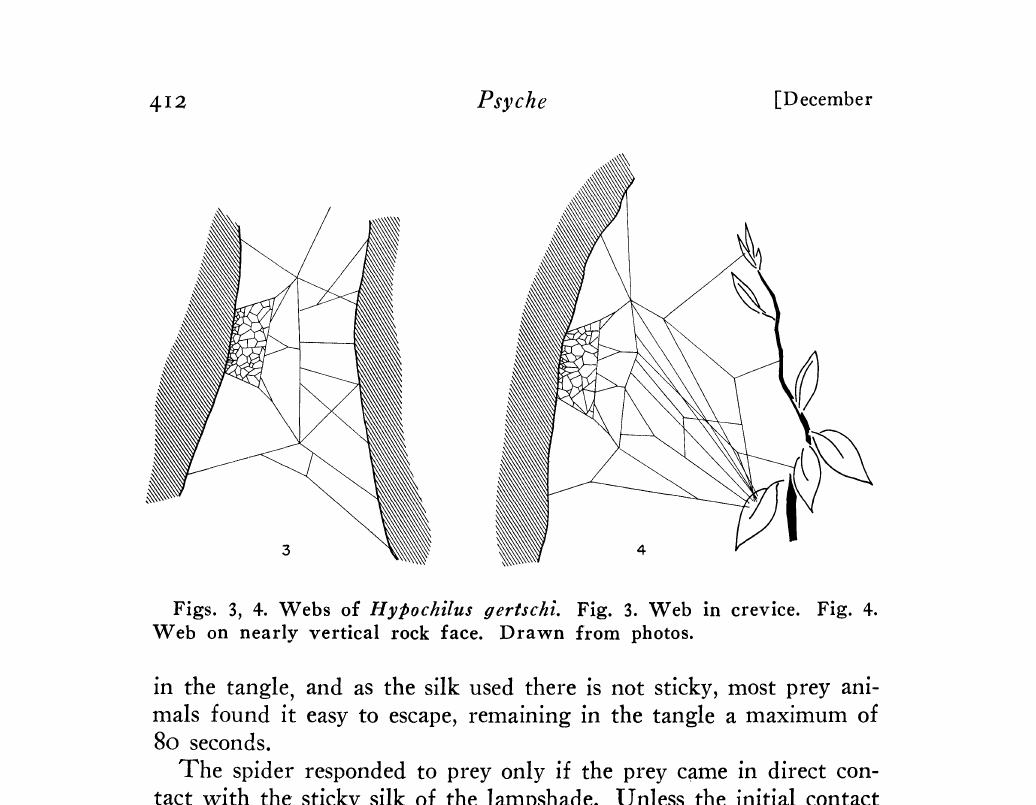
Figs. 3, 4. Webs of Hykochilus gertschi. Fig. 3. Web in crevice. Fig. 4. Web on nearly vertical rock face. Drawn from